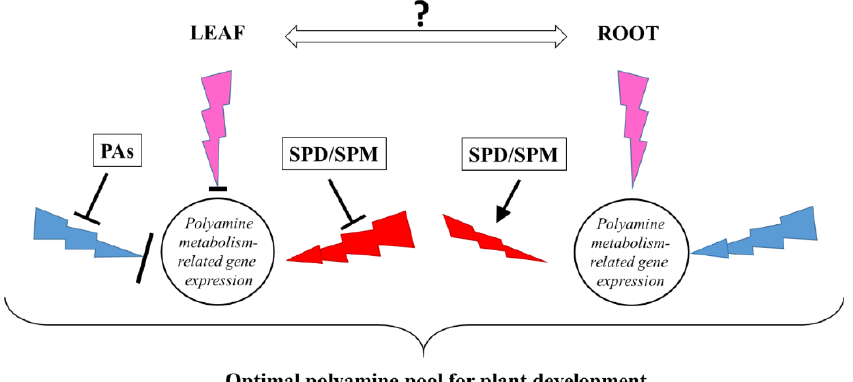
Figure 9. Schematic figure on the effect of polyamines (PAs) (SPD: spermidine; SPM: spermine) treatments in the leaves and roots of plants grown under three light regimes (blue lightning arrows indicate blue light, red lightning arrows indicate red + far-red light, and the pink ones the combination of blue and red + far-red, called pink light) compared to white light conditions without any polyamine treatment. Supplementary Materials: The supporting information can be downloaded at: www.mdpi.com/xxx/s1.